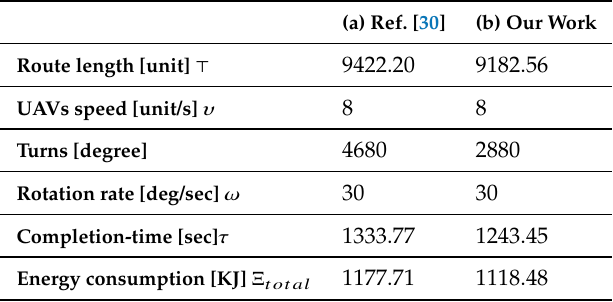
Table 5. Coverage path planning (CPP) path provided in Ref. [30] vs. our CPP using our PPS-L partition method.